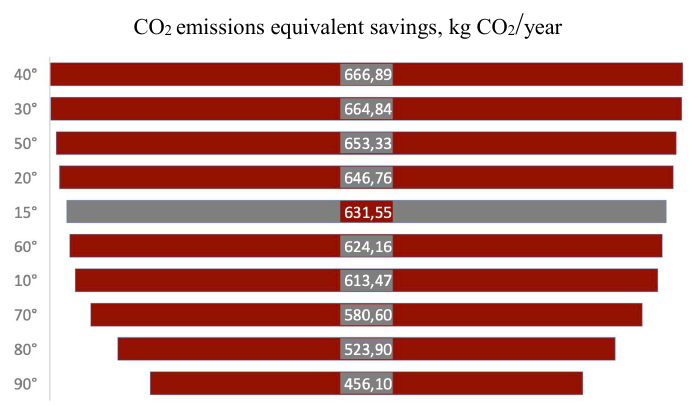
Fig. 7. CO 2 emissions equivalent savings in kg CO 2 /year at different roof tilt. The value obtained when the angle is equal to 15° (case study) are pointed out in